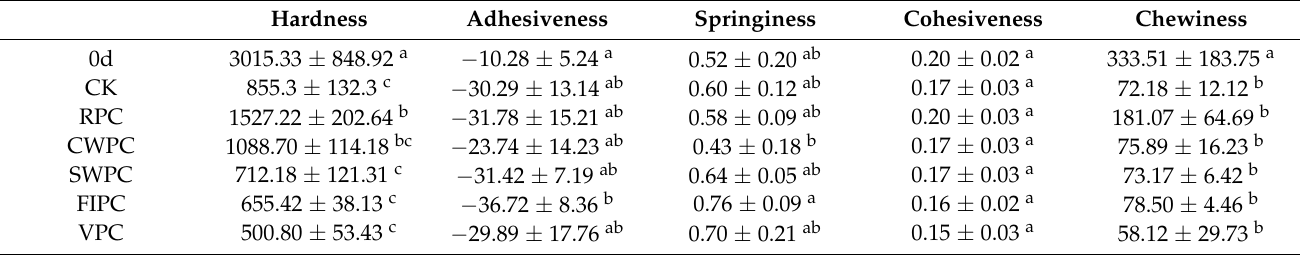
Table 1. Hardness, stickiness, elasticity, cohesiveness, and chewiness of yellow peaches on day 0 and the 15th day of storage.